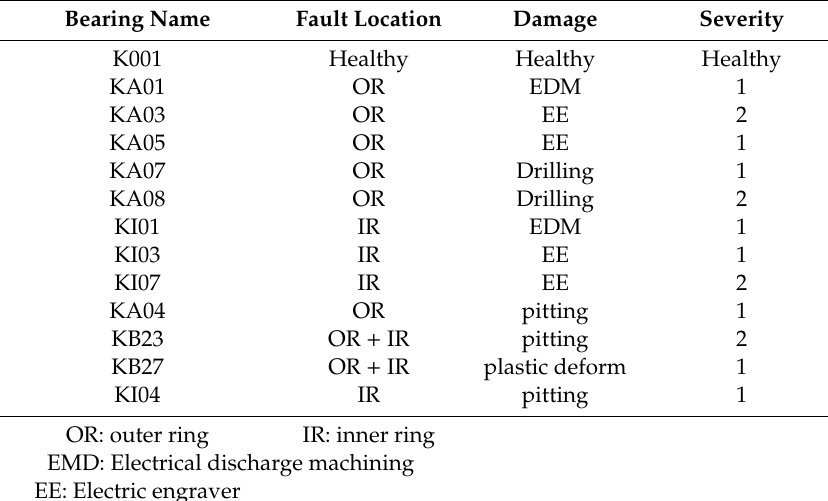
Table 1. Details of Paderborn University (PU) bearing